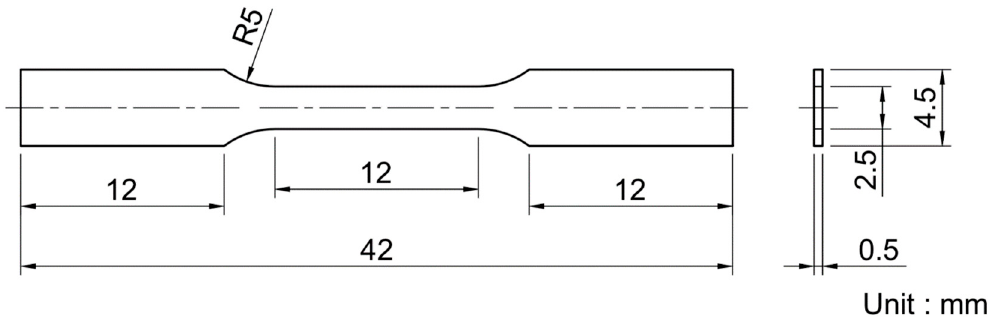
Figure 1. Dimensions of the specimens used in the tensile tests.